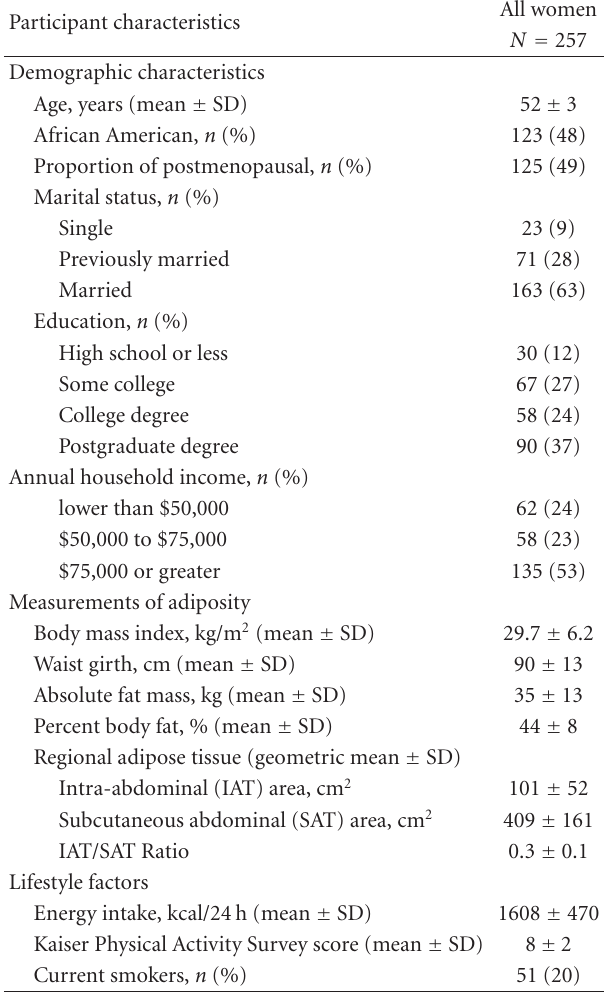
Table 1: Participant characteristics.